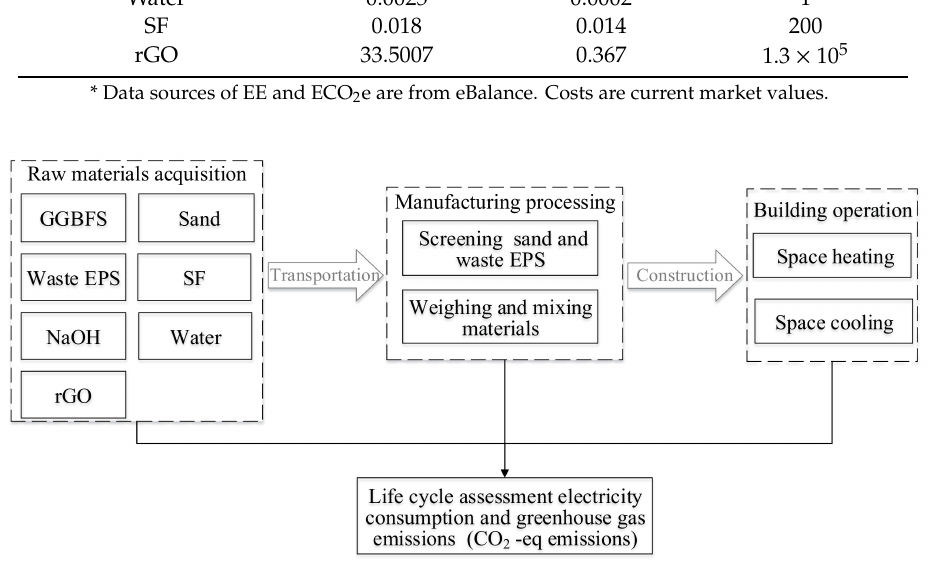
Figure 7. Life-cycle boundary of the life cycle assessment (LCA) evaluation.